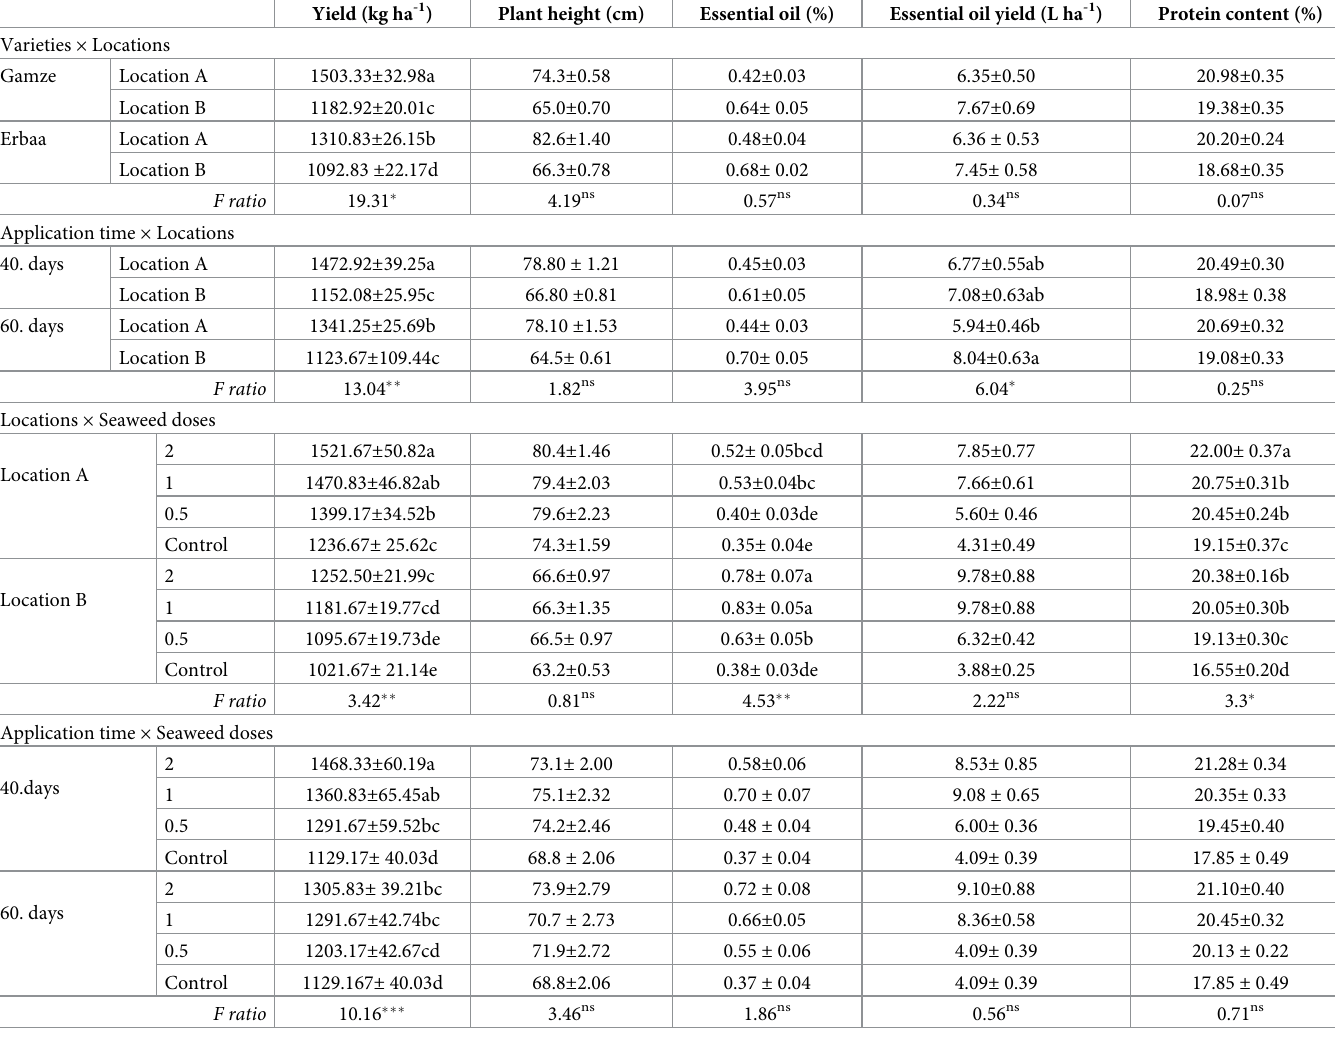
Table 4. Interactions of seaweed applied at different times and doses and at two different locations ( ± standard